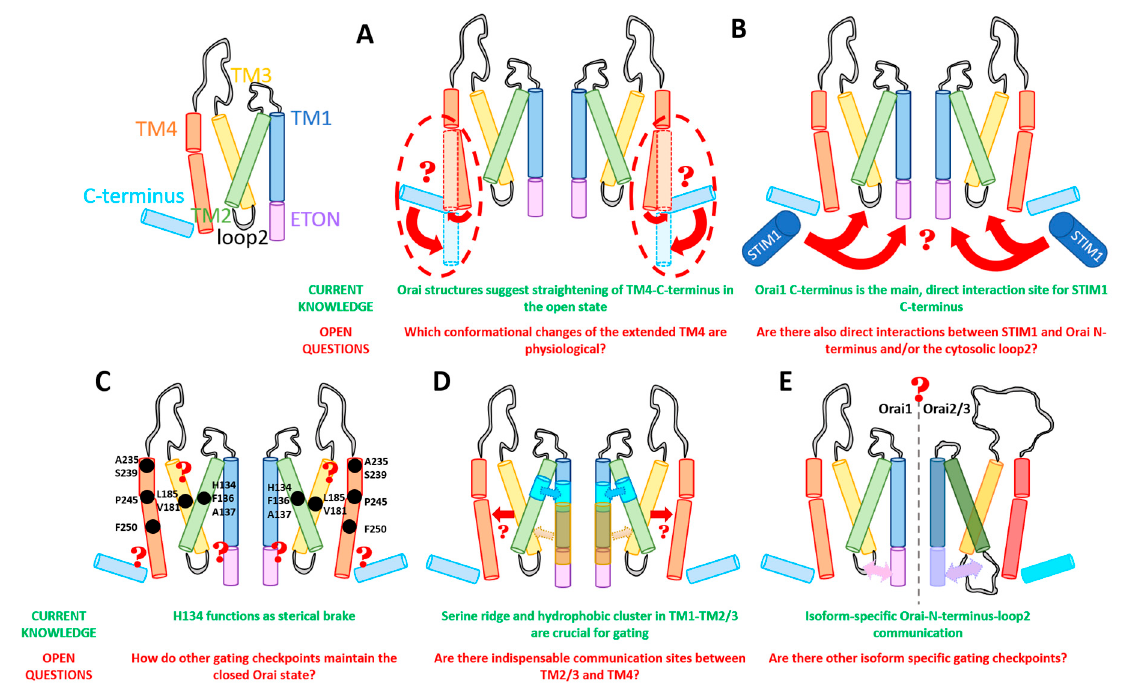
Figure 6. Open questions. The simplified model scheme summarizes the current knowledge of Orai1 channel gating and so far open corresponding questions. Scheme of one Orai subunit with the the main regions indicated. ( A ) The available dOrai structures suggest a straightening of the TM4-C-terminus regions, however, whether those changes are also occurring physiologically needs to be confirmed. ( B ) The direct interaction of STIM1 with the C-termini of Orai was proven. Moreover, the loop2 region communicates with STIM1 in relaying a gating signal to the pore. While the interaction site of STIM1 and Orai1 C-terminus is well-defined, potential binding pockets of STIM1 with the Orai1 N-terminus or the loop2 still need to be resolved. ( C ) Position H134 is the best characterized gating checkpoint within Orai1 likely functioning as a steric brake to maintain the closed state of Orai1. How this principle is applicable to other gating checkpoints is still unknown. ( D ) While the interacting regions between TM1 and TM2/3 are well-defined, not so much is known about the interface formed by TM2/3 and TM4. ( E ) Several isoform-specific features of Orai channels have been identified. Whether Orai channel activity is controlled via additional sites in an isoform-specific manner remains to be investigated.